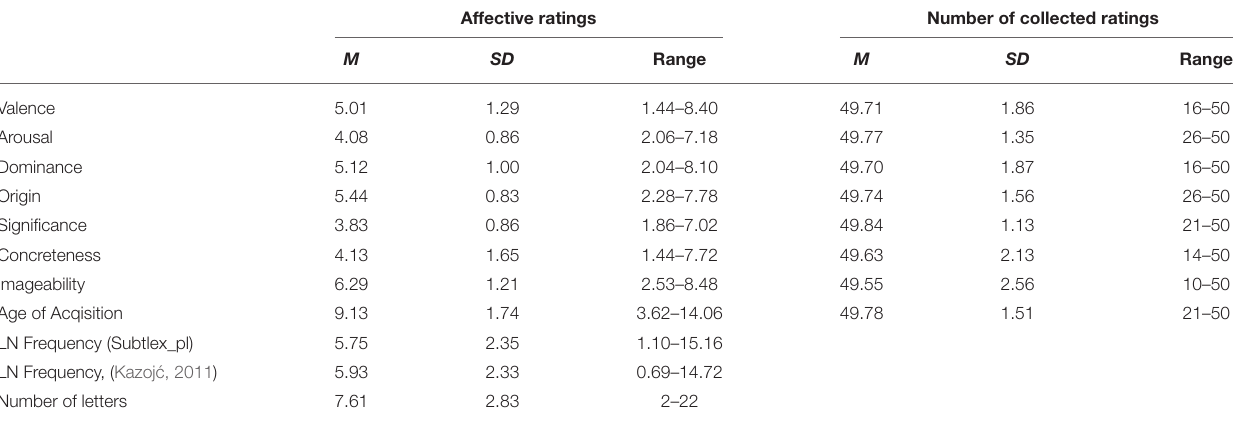
TABLE 2 | Summary of variables included in the word list with means ( M ), standard deviations ( SD ) and ranges for all